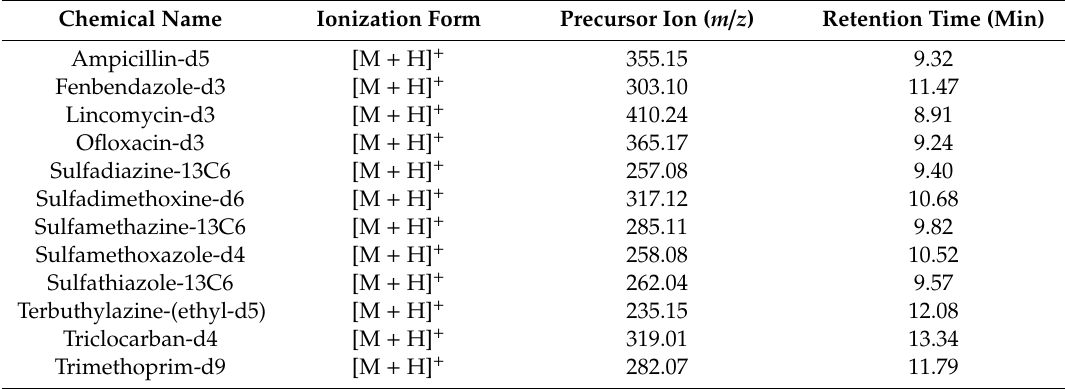
Table 2. Analytical data of HRMS for the internal standards in this